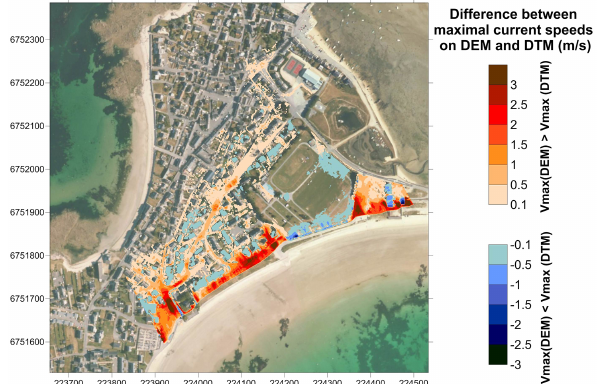
Figure 13. Difference between the maximum current speeds ob- tained inland during the SURF-WB simulations, with and without an explicit representation of the buildings ( V max DEM – V max DTM )